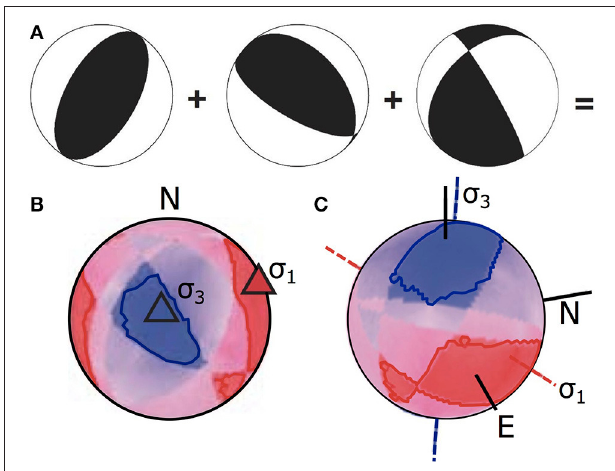
FIGURE 3 | Results of the BRTM applied to a synthetic dataset (A) made up of three FPSs (black = dilatational dihedra); (B) 2-D plot on a Lambert equiareal, lower-hemisphere projection; (C) tridimensional view of the BRTM results over the focal sphere (After: D’Auria and Massa, 2015, modified).